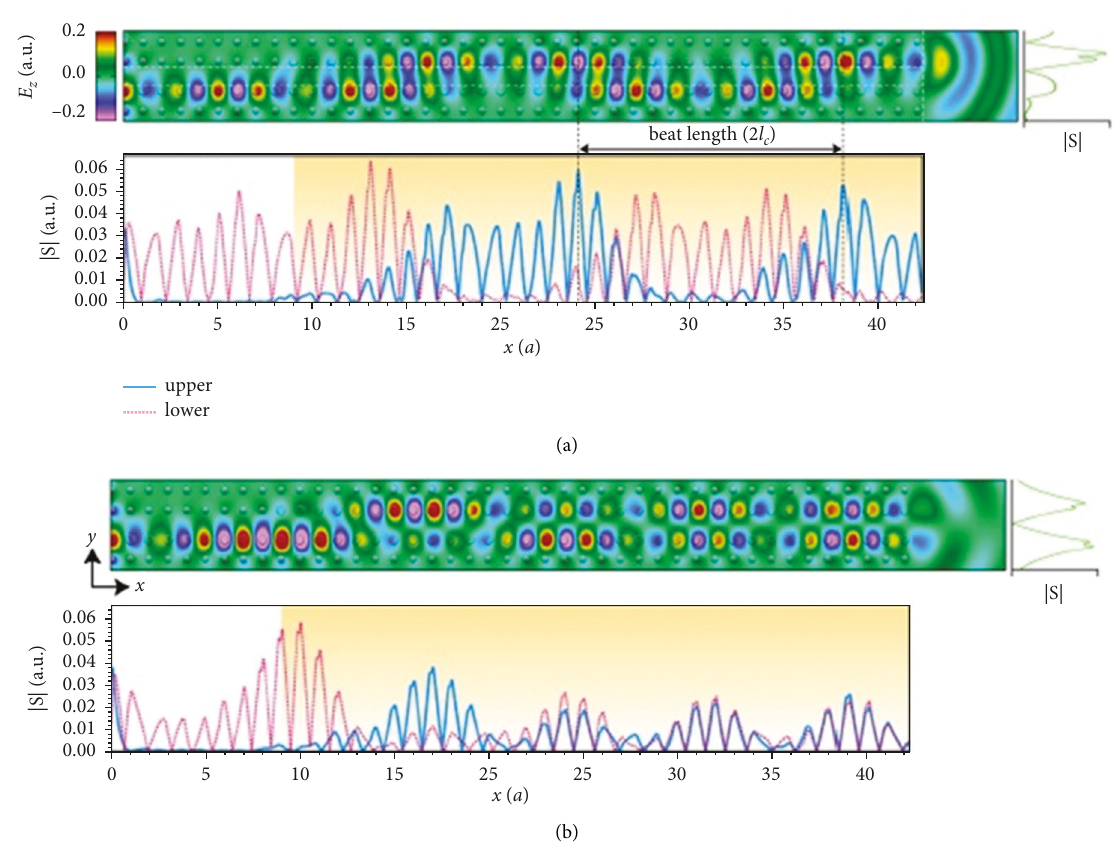
Figure 7: (Color online) simulation results for ω along the surfaces (bottom panels) and at the output side (to the right of FDTD